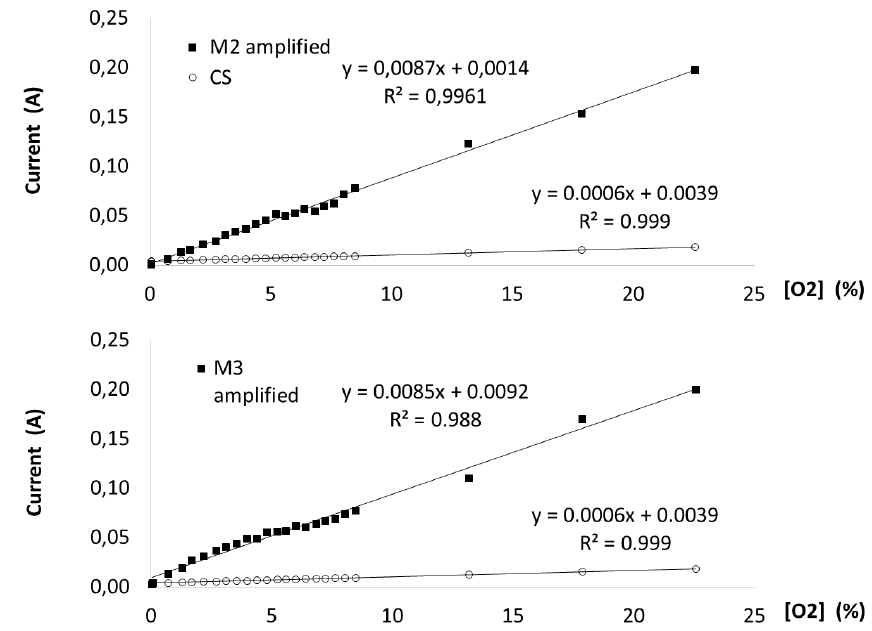
Figure 4. The MG and MP oxygen sensor characterizations.